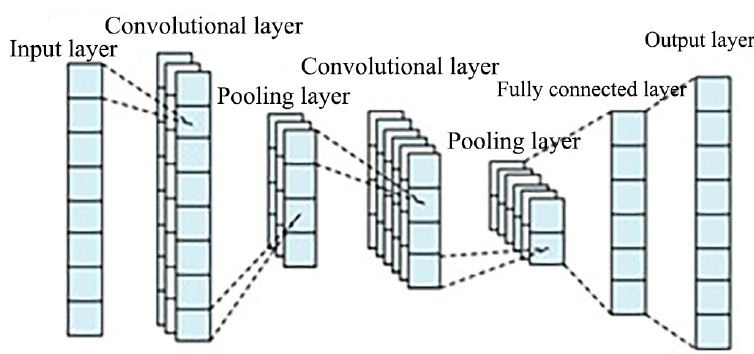
Figure 1. CNN structure diagram.